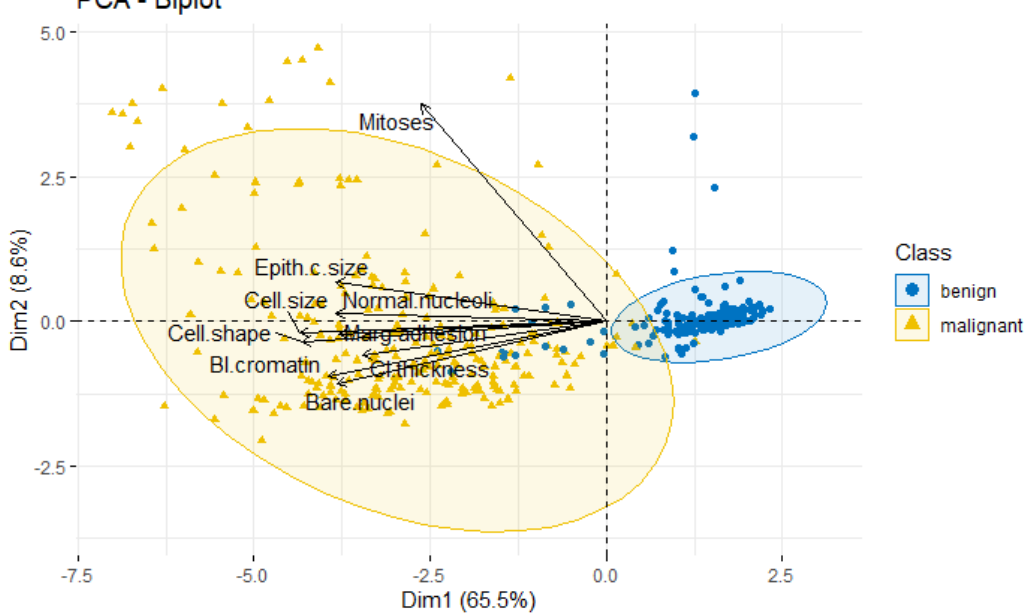
Figure 9. Breast cancer PCA